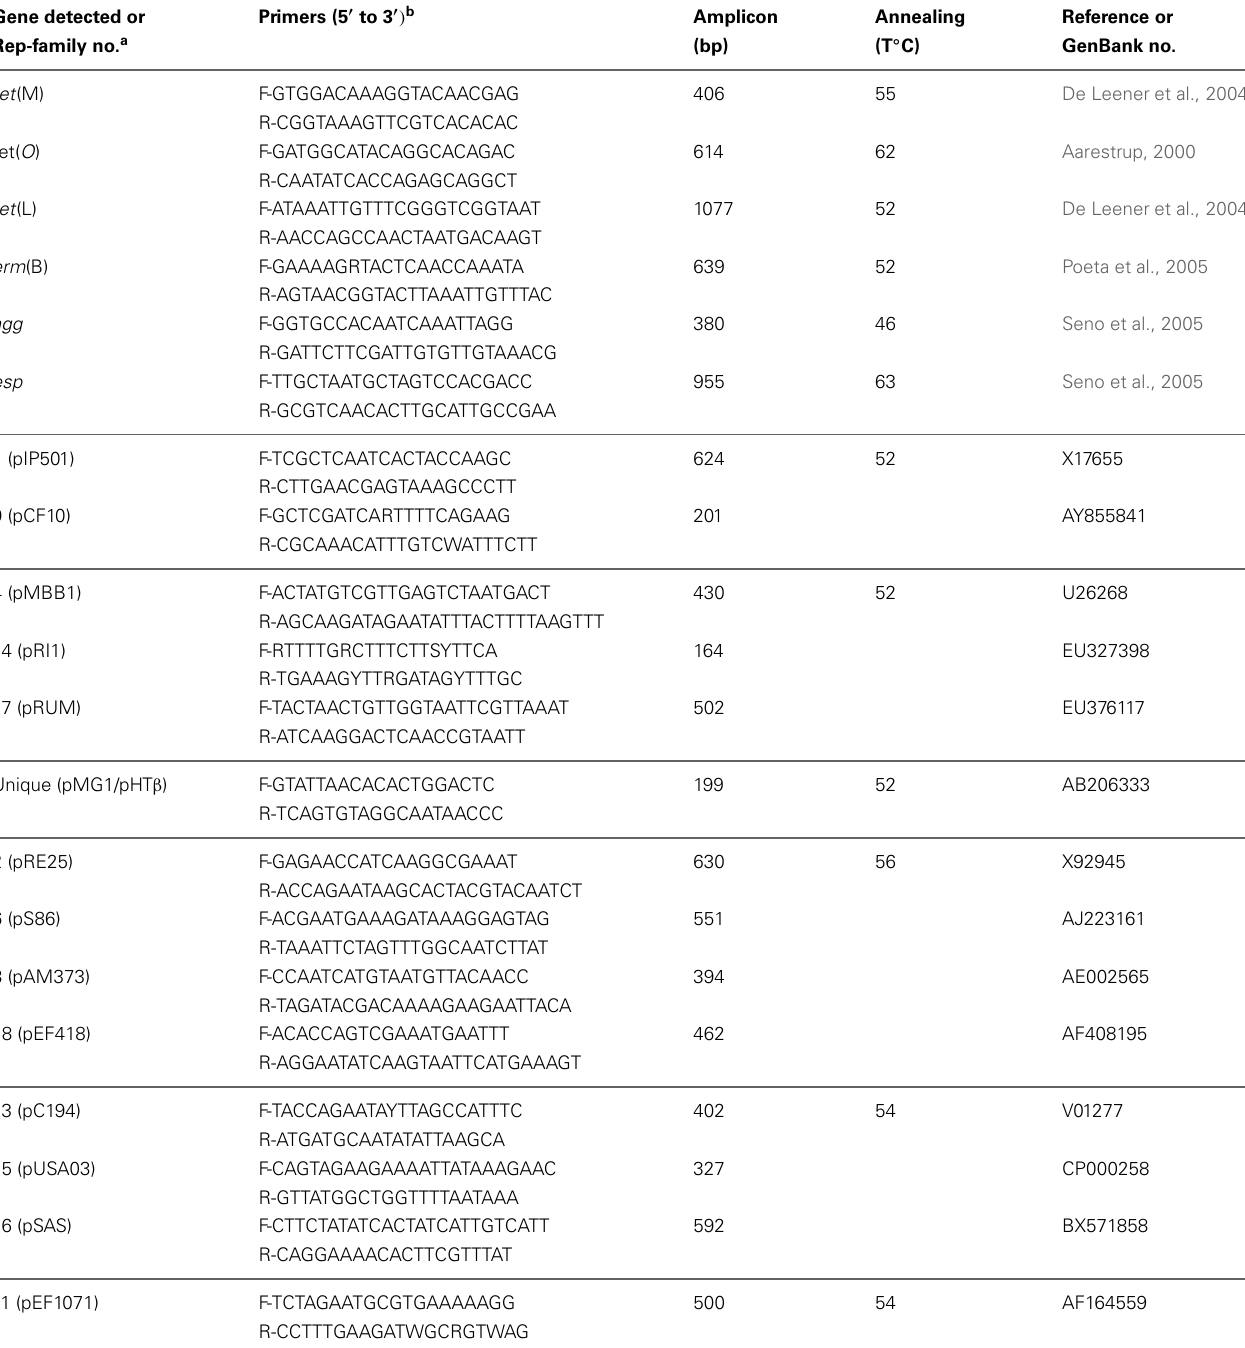
Table 2 | Primers and conditions used in PCR for confirmation of microarray results and for rep -like genes identification. Gene detected or Primers (5 (cid:2) to 3 (cid:2) ) b Amplicon Annealing Reference or Rep-family no.